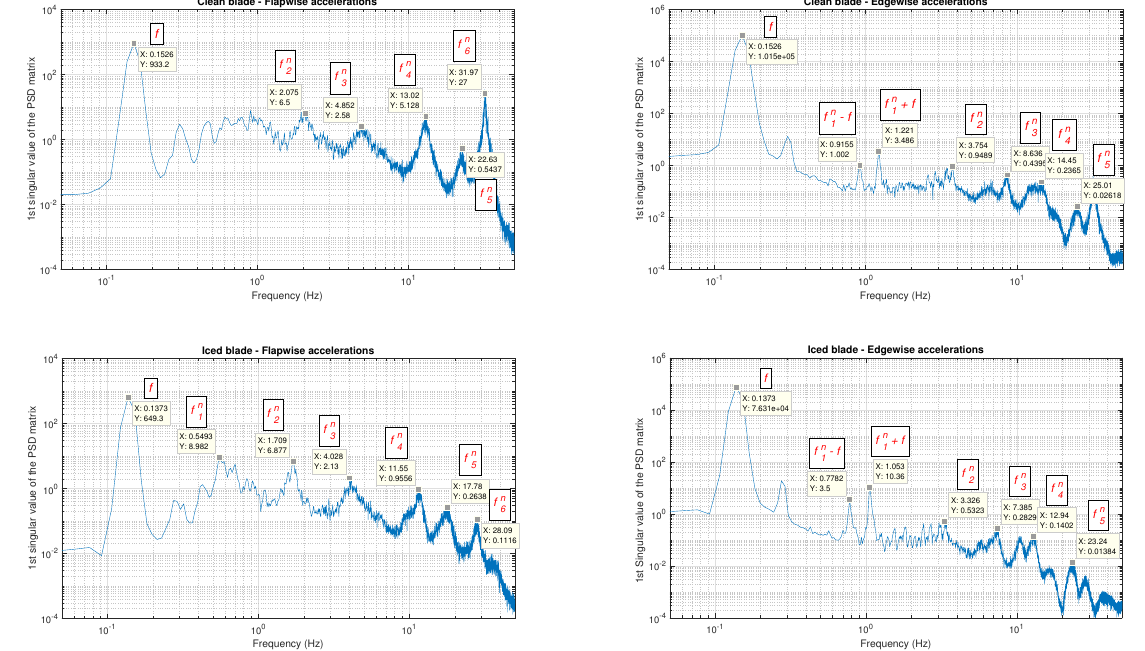
Figure 18. Natural frequencies extracted using the FDD technique on vibration accelerations simulated using clean and iced blades of the NREL 5 MW wind turbine model in the FAST tool. Note: ‘ f ’ refers to the rotational frequency of the turbine, ‘ f n ’ refers to the i th natural frequency of the i